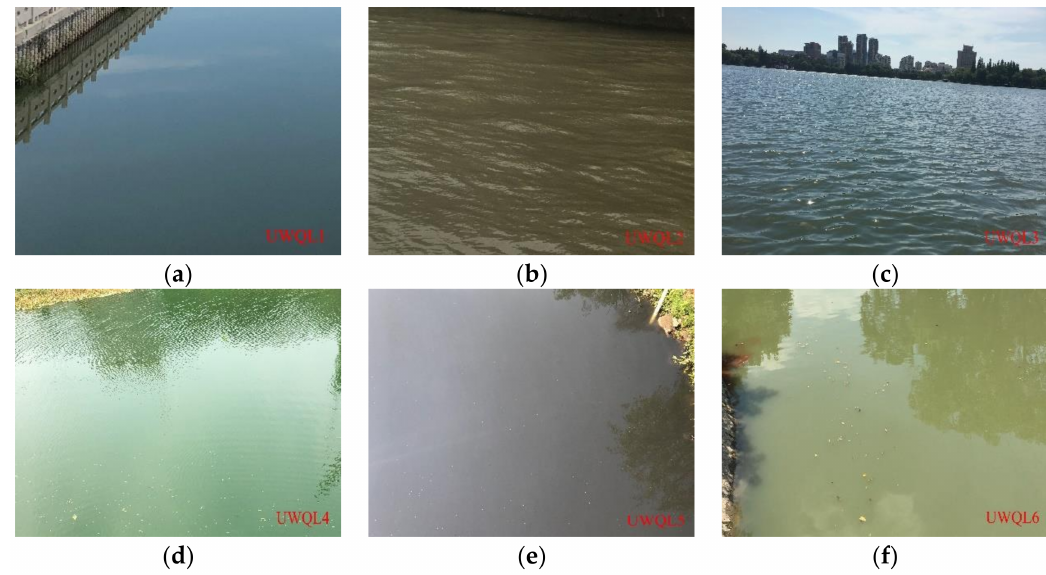
Figure 7. Field photographs of six typical water areas for ( a ) UWQL1; ( b ) UWQL2; ( c ) UWQL3; ( d ) UWQL4; ( e ) UWQL5; ( f )